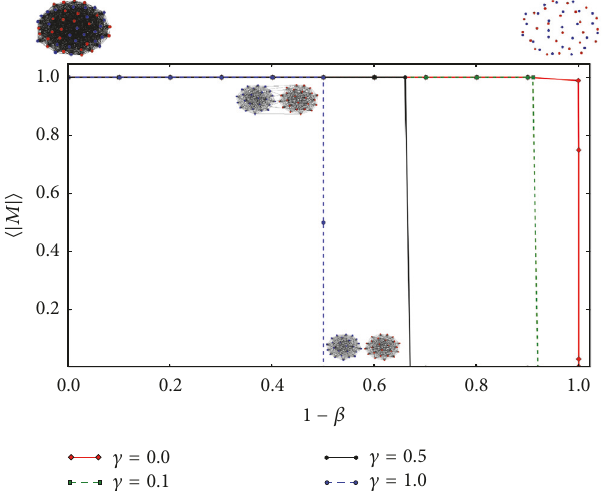
Figure 5: (Absolute) average magnetization |𝑀| in function of 1 − 𝛽 , for different 𝛾 , as indicated in the legend. The small networks decorate the plot, showing the dilution over the abscissa. Notably, the two inner small networks refer to values of 𝛾 = 1.0 and to 𝛽 slightly higher and lower than 0.5 . Results have been averaged over different simulation runs.